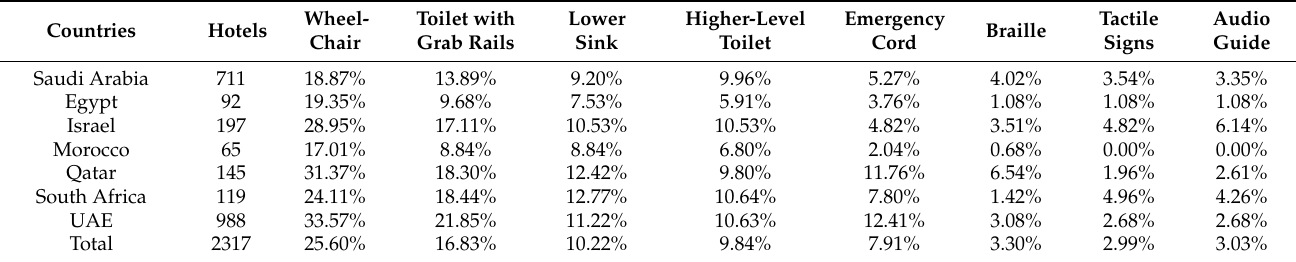
Table 7. Distribution of the accessible installations for the countries in